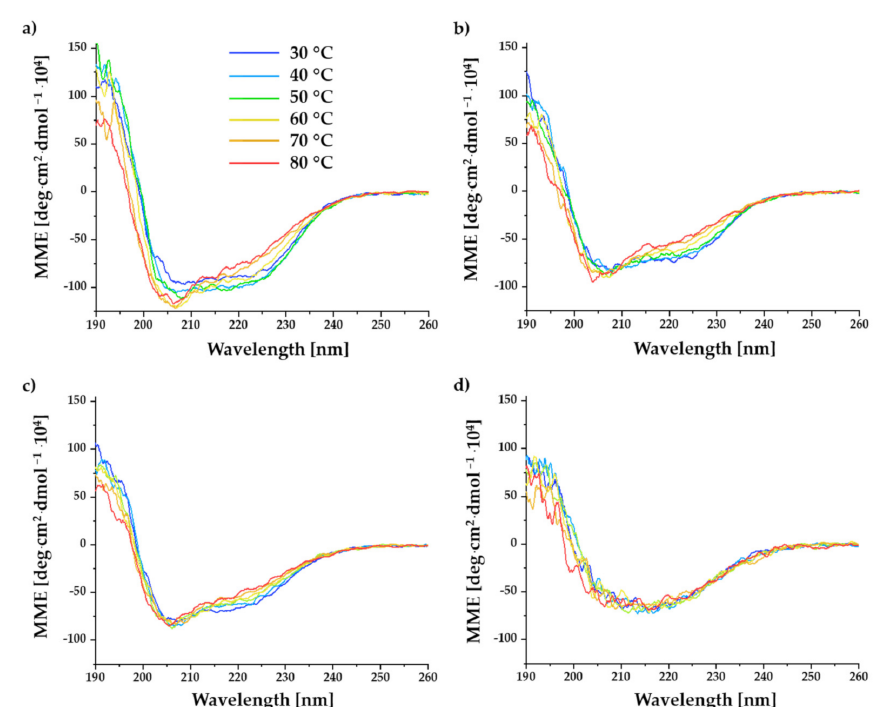
Figure 4. CD spectra of the BITC- α -LA derivatives recorded at different temperatures ranging from 30 to 80 ◦ C. Control sample ( a ), BITC- α -LA derivative “low” ( b ), BITC- α -LA derivative “medium” ( c ), and BITC- α -LA derivative “high” ( d